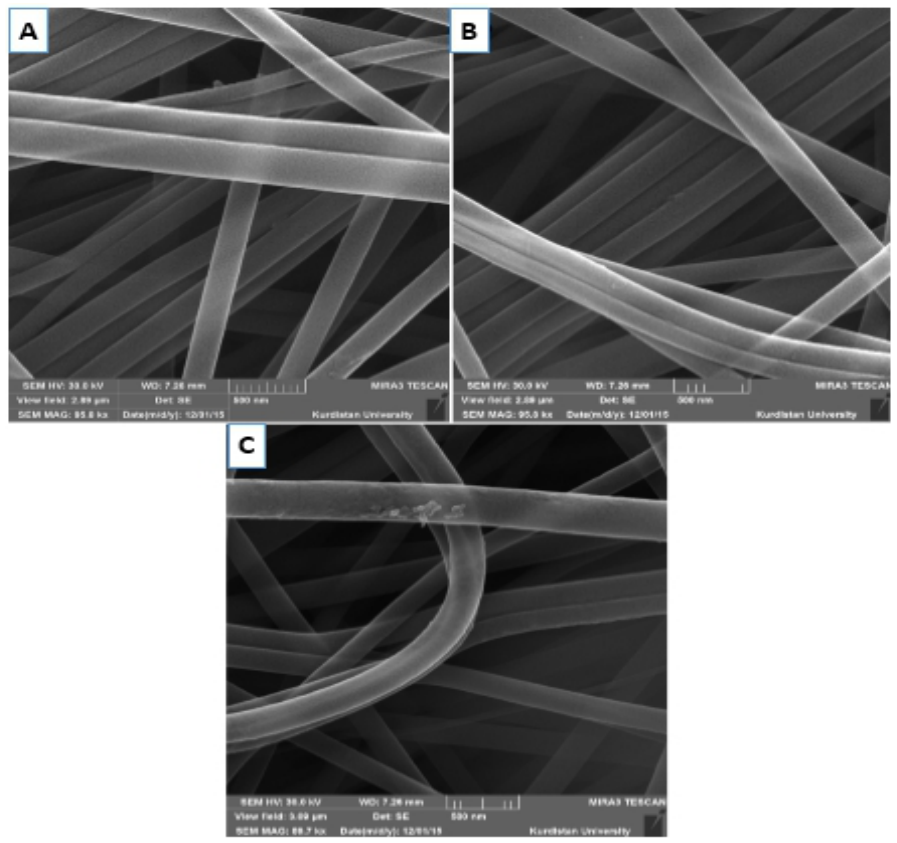
Fig. 3. The effect of nanoparticle loadings (A) 0.01 wt%, (B) 0.1 wt%, and (C) 1 wt% on the morphological features of the nanofibers